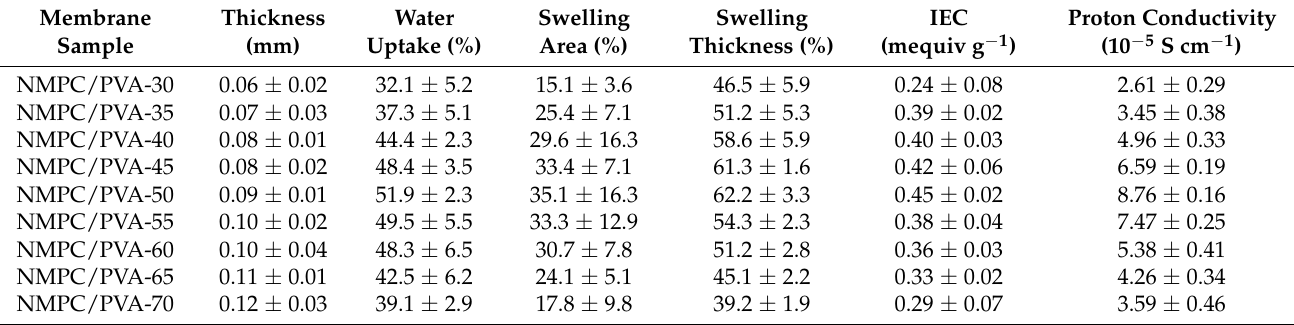
Table 1. Thickness, water uptake, swelling area, swelling thickness, IEC, and proton conductivity of the NMPC/PVA composite membranes with different